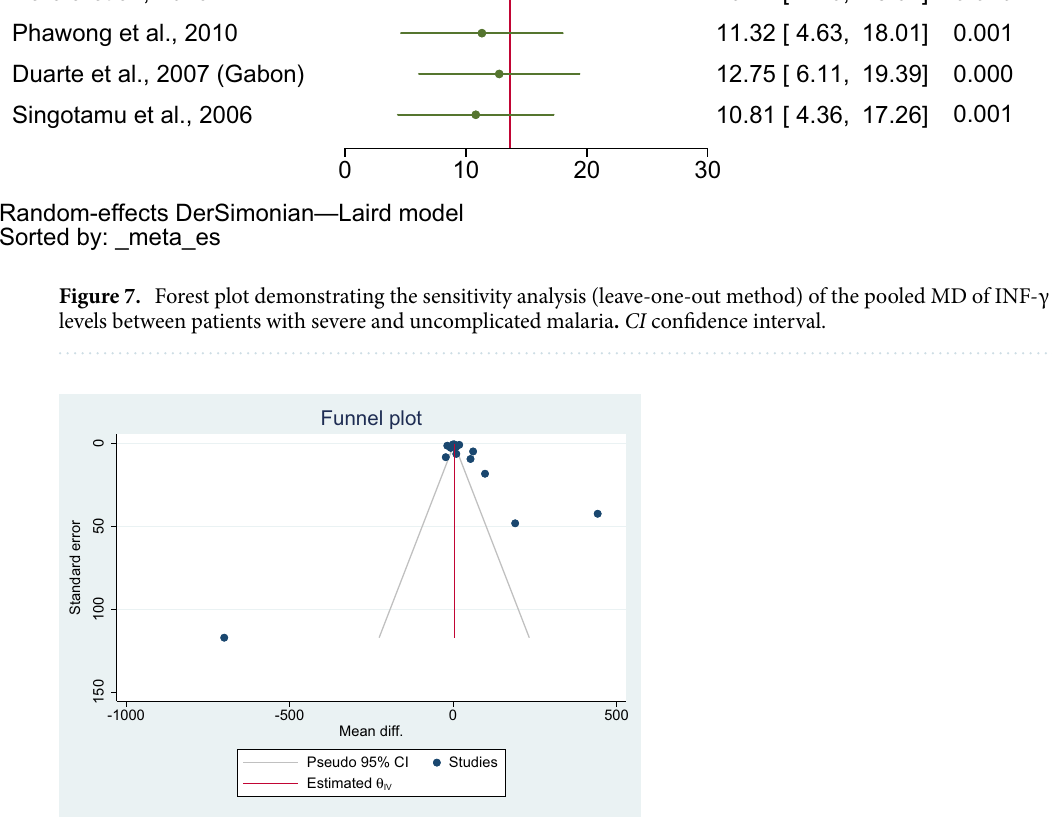
Figure 8. Funnel plot of the studies included in the meta-analysis between patients with severe malaria and uncomplicated malaria. CI confidence